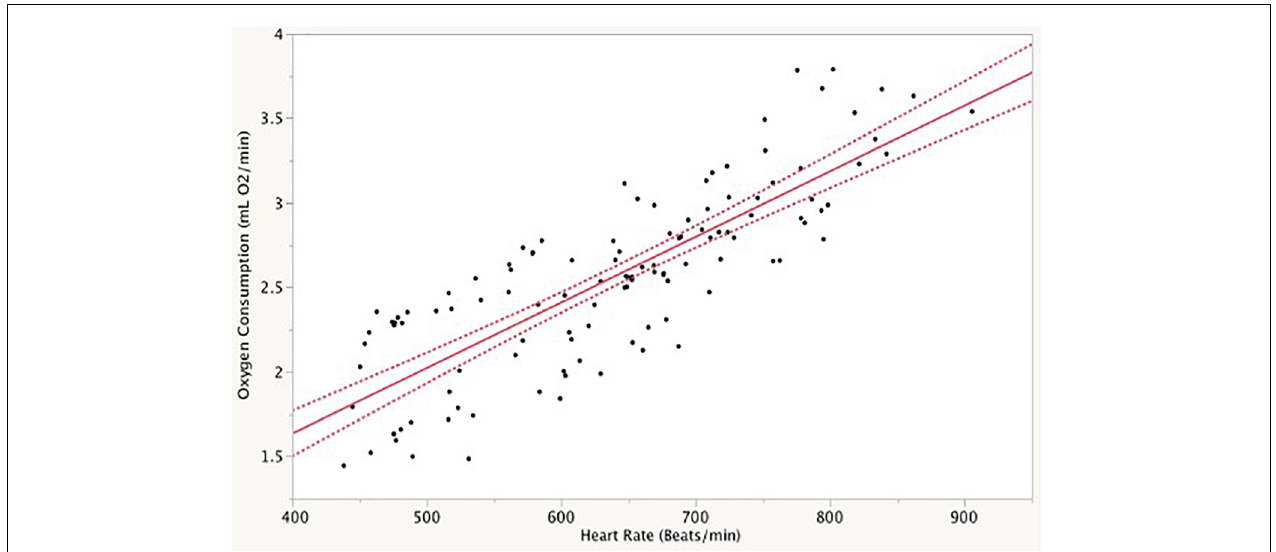
FIGURE 1 | Relationship between oxygen consumption (mL O 2 /min) and heart rate (beats/min) of 6 white-crowned sparrows measured over a 2-h time period. Line indicates best fit regression with 95% confidence intervals. Each data point reflects a 5-min average.